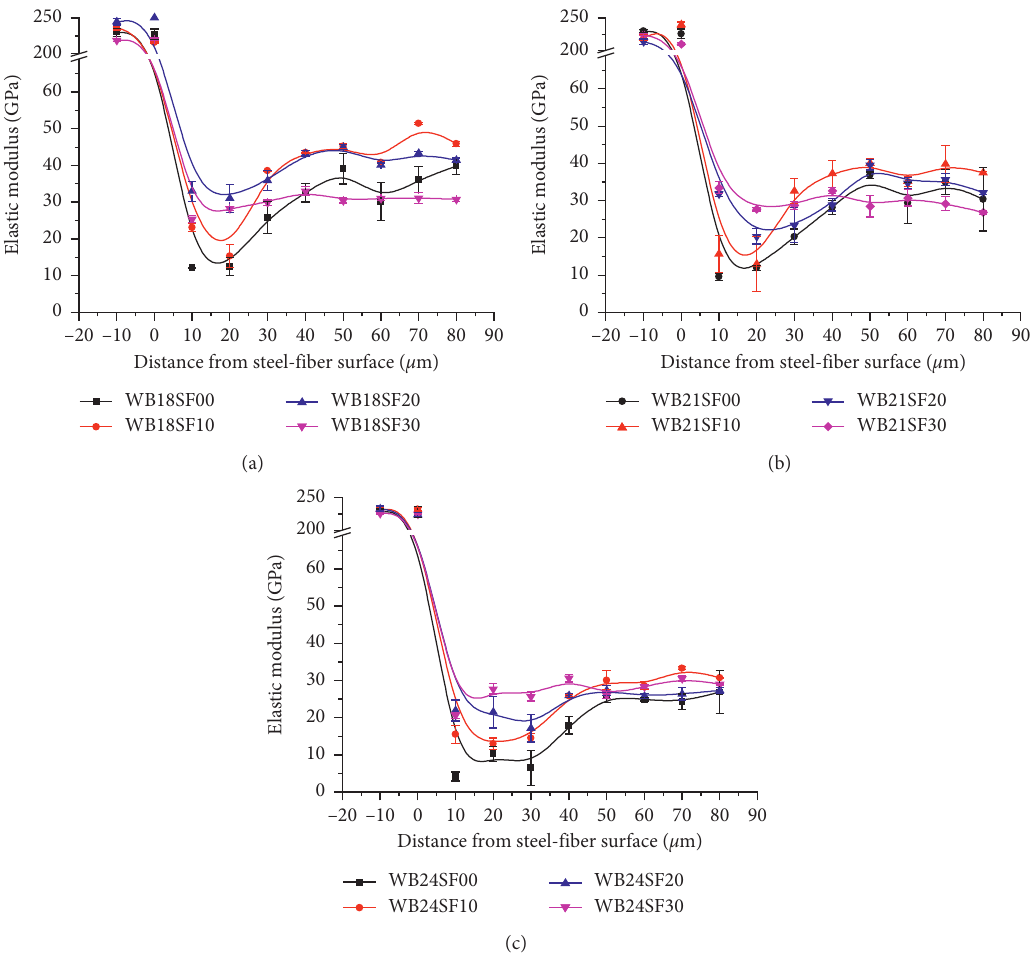
Figure 8: Elastic modulus with distance from the steel-fiber surface for different silica fume contents and water-binder ratios. (a) Water- binder ratio of 0.18. (b) Water-binder ratio of 0.21. (c) Water-binder ratio of